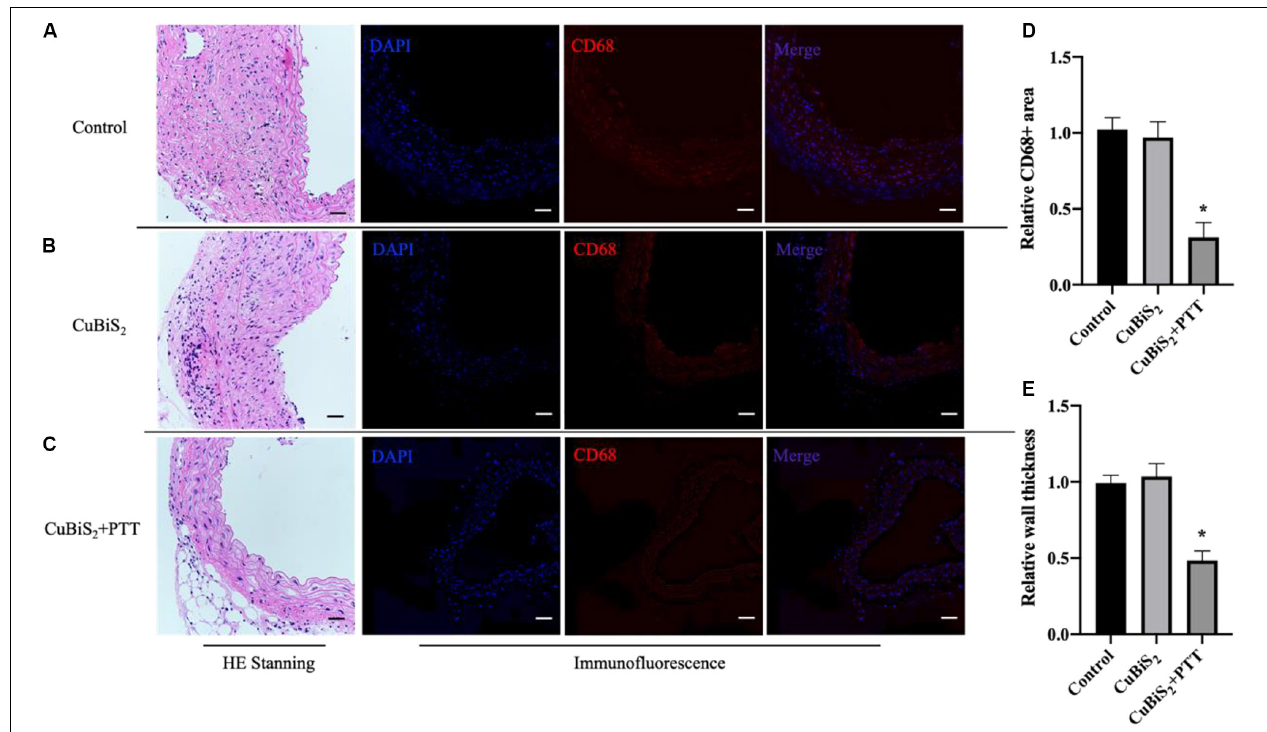
FIGURE 8 | CuBiS 2 NPs based PTT mitigated arterial inflammation in vivo . (A–C) Representative of HE and Immunofluorescence stanning of carotid artery from control group, CuBiS 2 group and CuBiS 2 + PTT group, respectively. (D,E) Representative of CD68 + macrophages positive area and artery wall thickness in each group, respectively. Scale bar: 50 µ